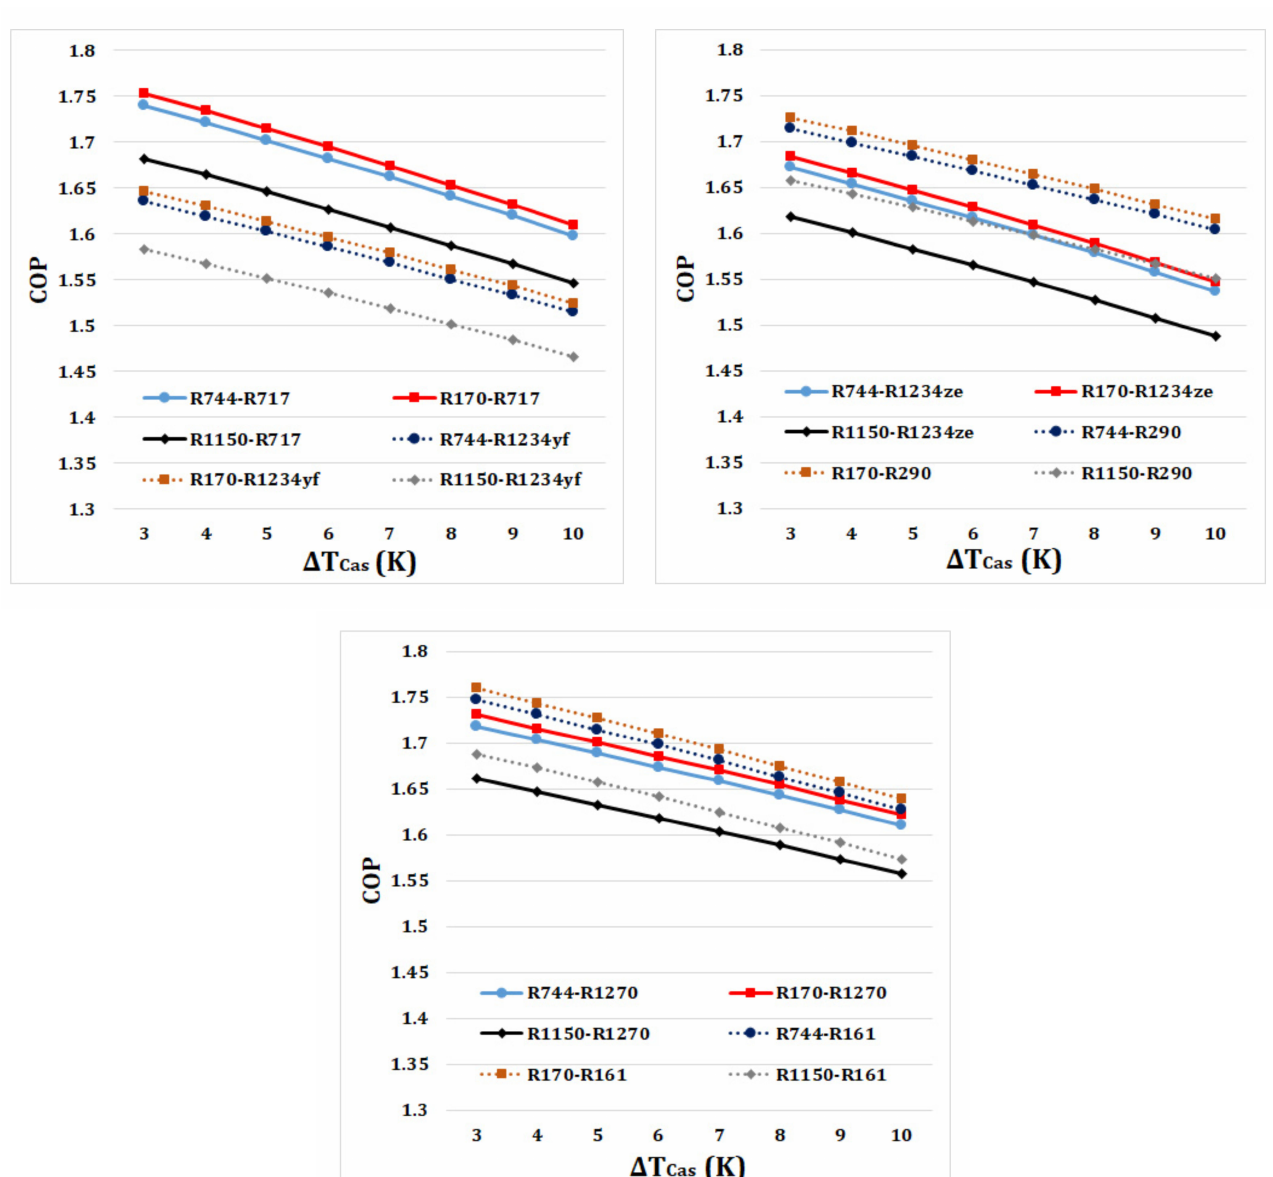
Figure 2. Effect of temperature difference in the cascade heat exchanger ( ∆ T Cas ) on the COP for different refrigerant